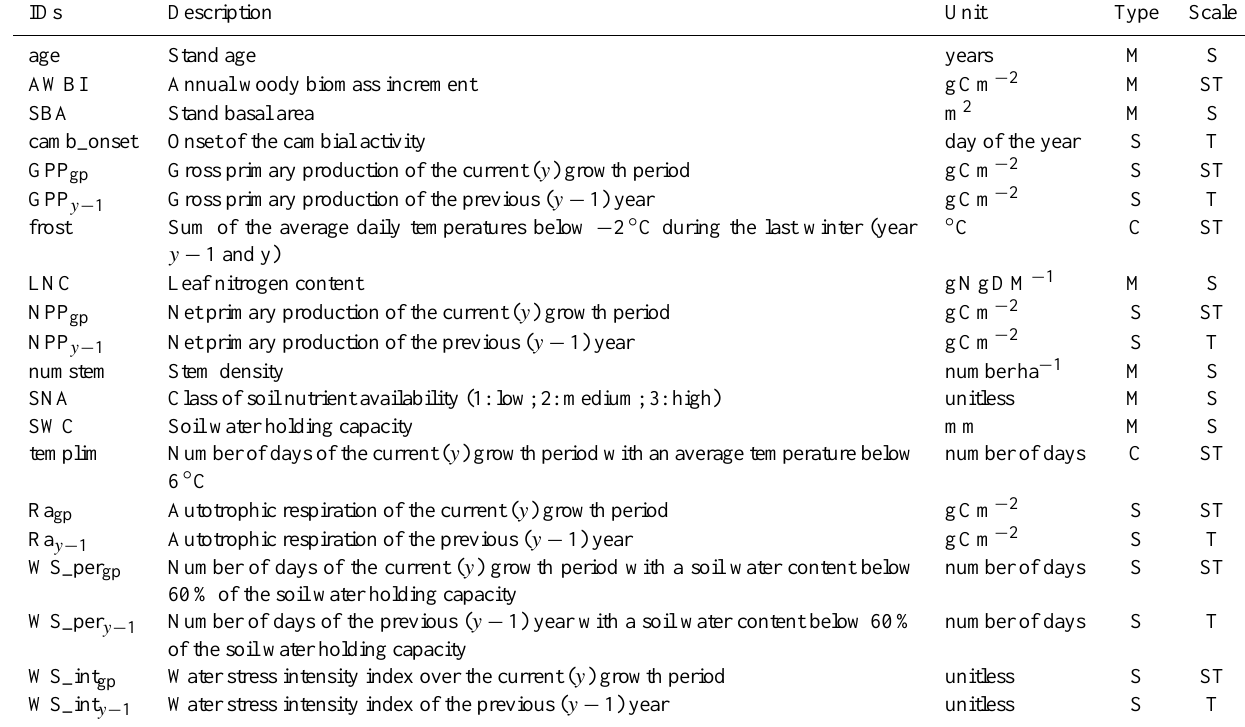
Table 2. Description of the explanatory variables considered in the analyses. The type category indicates the source of the data: measurement (M), SAFRAN climate database (C) or CASTANEA simulations (S). Scale categories indicate the variables considered in spatial (S) and/or temporal (T)